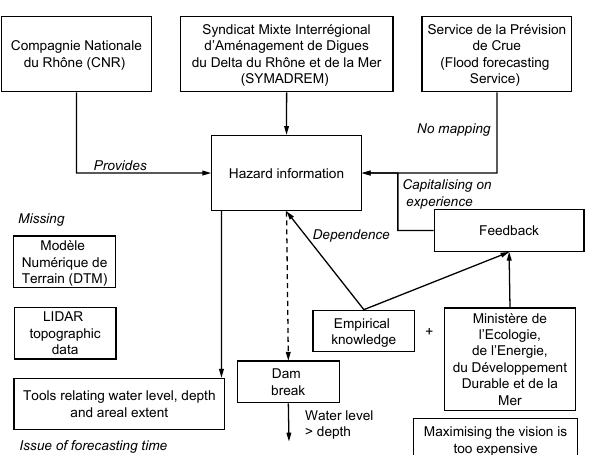
Fig. 6. Entity diagram for flood hazard mapping for the Tarascon PCS developed during the